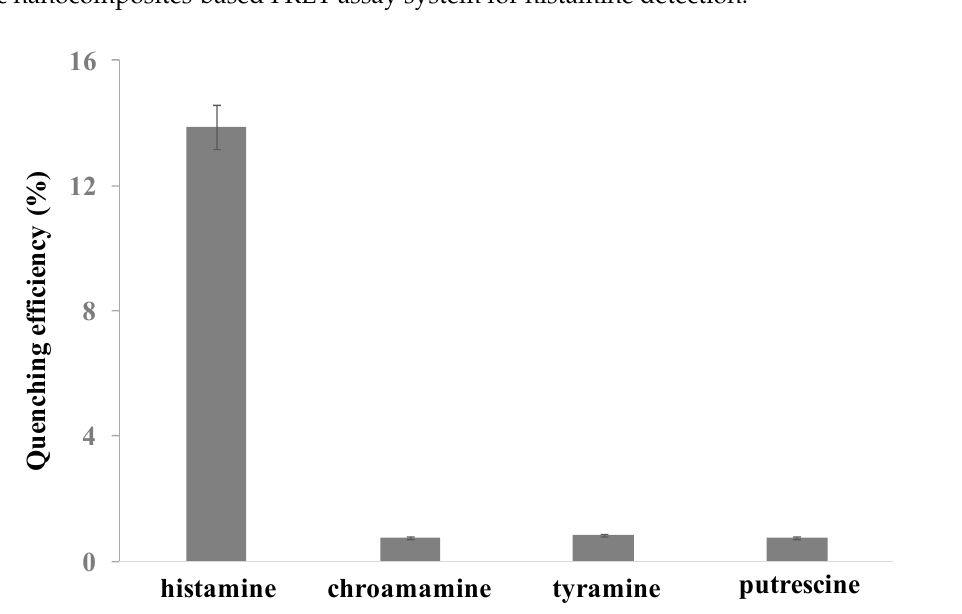
Figure 5. Comparison of the quenching efficiency of histamine, chroamamine, tyramine and putrescine detection.